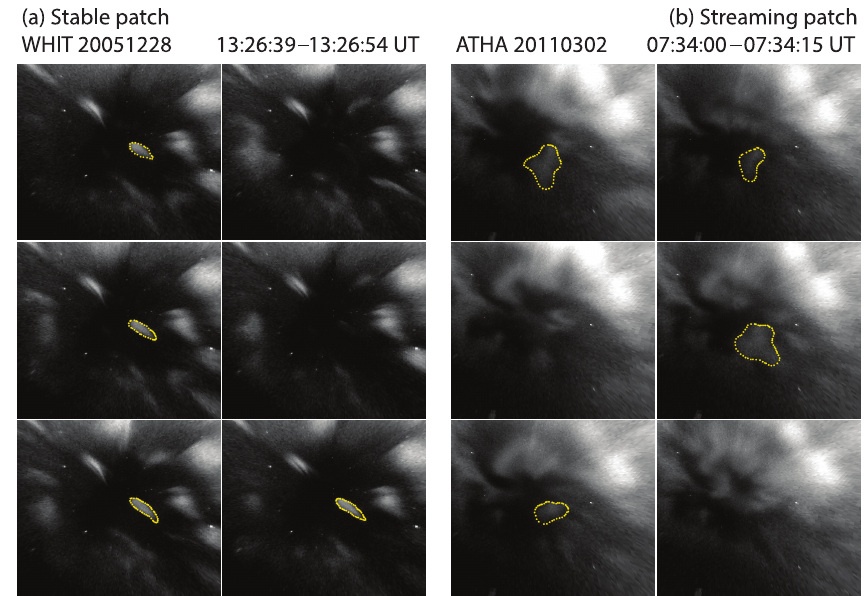
Figure 1. (a) An example of a stable pulsating auroral patch as described by Royrvik and Davis (1977). The images of this patch were cap- tured during the minute of 13:26UT on 28 December 2005 from Whitehorse THEMIS ASI. (b) An example of a streaming pulsating auroral patch as described by Royrvik and Davis (1977). The images of this patch were captured during the minute of 07:34UT on 2 March 2011 from Athabasca THEMIS ASI. Streaming describes how the area of a patch can grow or shrink while switching between bright and dim